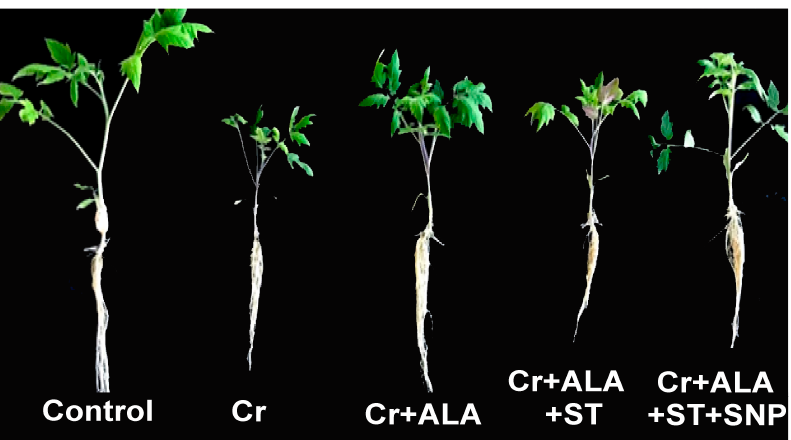
Figure 1. The effects of chromium (Cr) alone, or combined with 5-aminolevulinic acid (5-ALA), sodium tungstate (ST), and sodium nitroprusside (SNP) on tomato seedlings. Chromium was applied for 14 days on 13-day-old tomato seedlings pre-treated with 5-ALA for 3 days. Photographs were taken at the end of the experiments with both control seedlings and treatments being 27 days old.